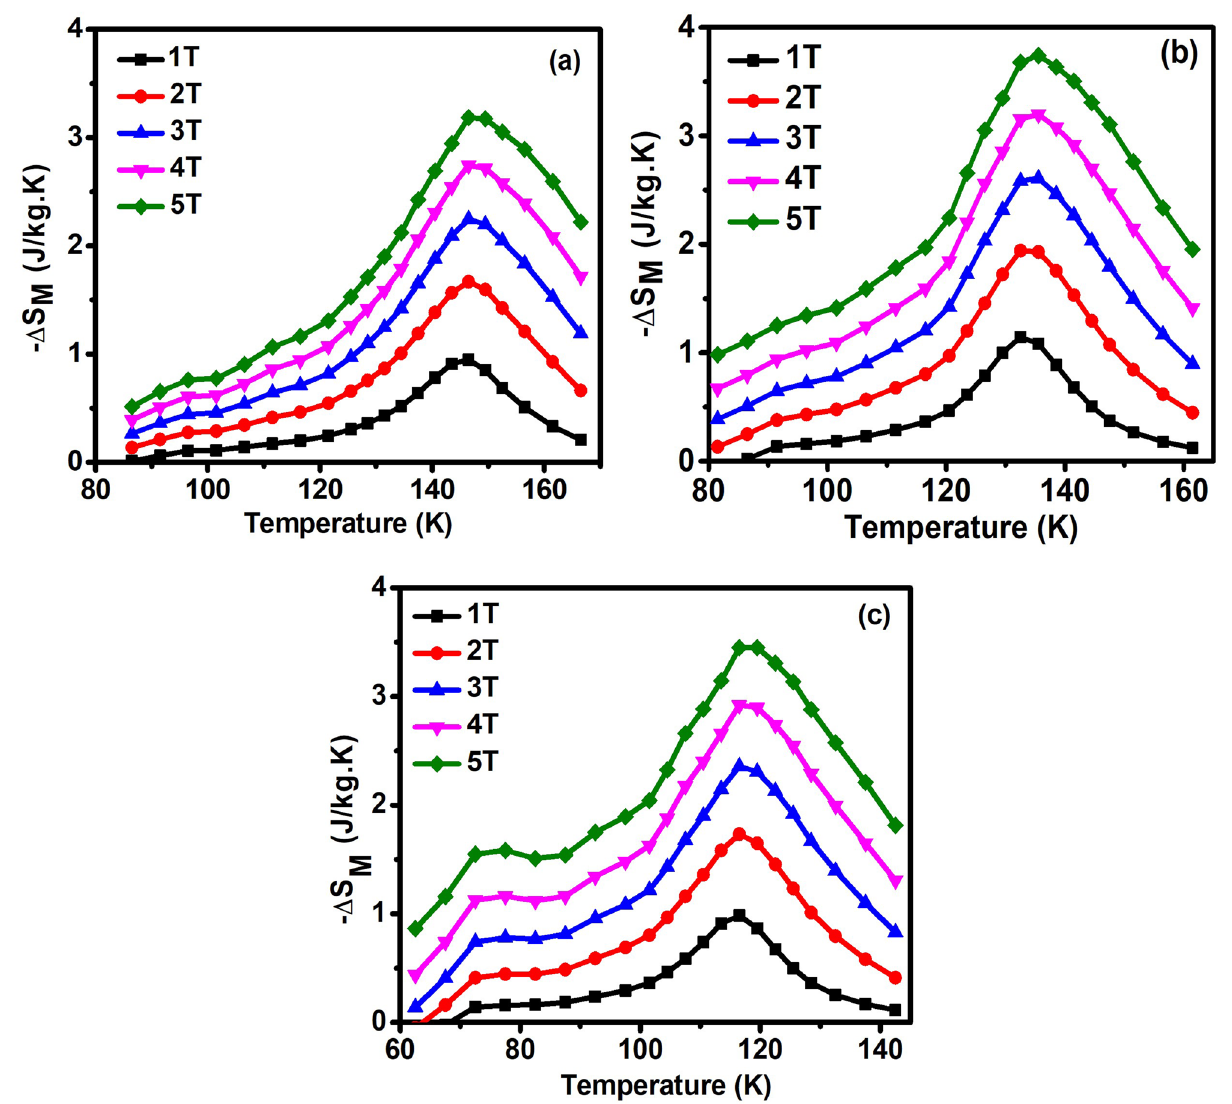
Figure 5. Magnetic entropy change (– ΔS M ) with respect of temperature in the magnetic field 1–5 T for ( a ) ENMO, ( b ) GNMO and ( c ) TNMO